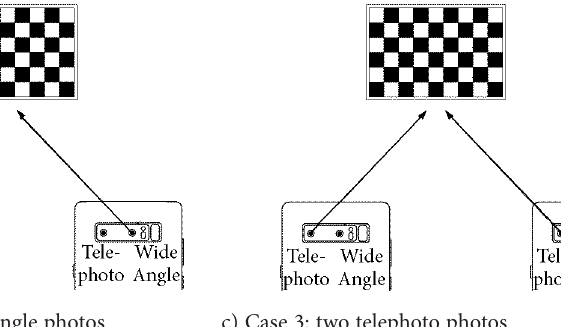
Figure 6. The three cases for